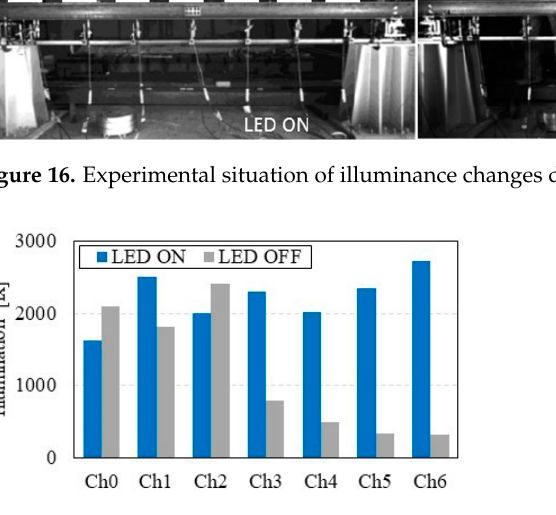
Figure 17. Illuminance change due to LED light on/off.